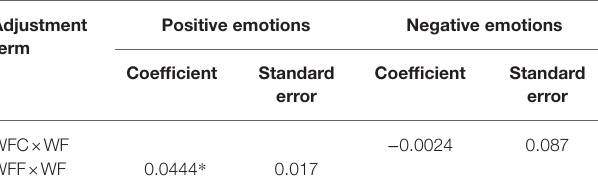
TABLE 6 | Test results of the adjustment effect of work flexibility (n =